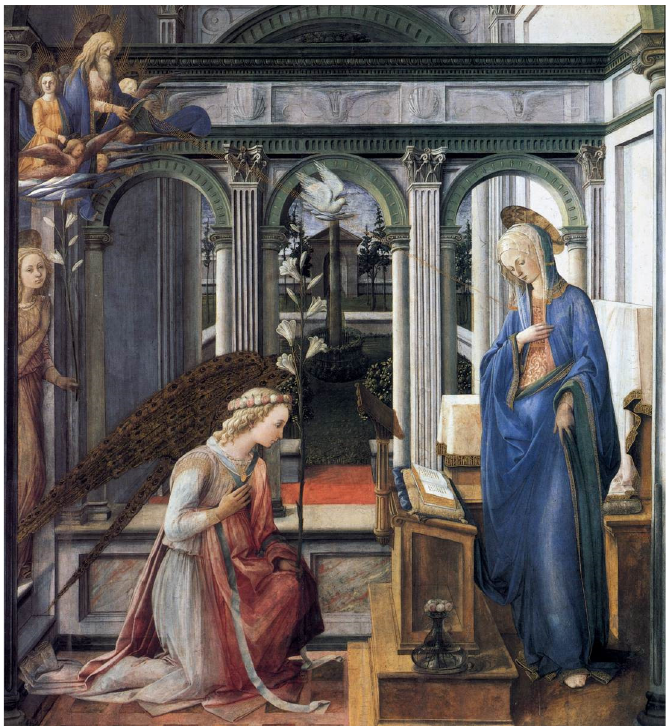
Figure 4. Fra Filippo Lippi, L’Annunciazione delle Murate , 1443. Alte Pinakothek, Munich. It is relevant to note that Lippi wants to highlight in this painting the double enclosure of the garden ( hortus conclusus ), perceivable through the three arches: the first enclosure is a low white wall in the mid-ground; the second one, more strong and high, is the heavy wall stretching out on both sides in the background, with a wide door under a triangular pediment.